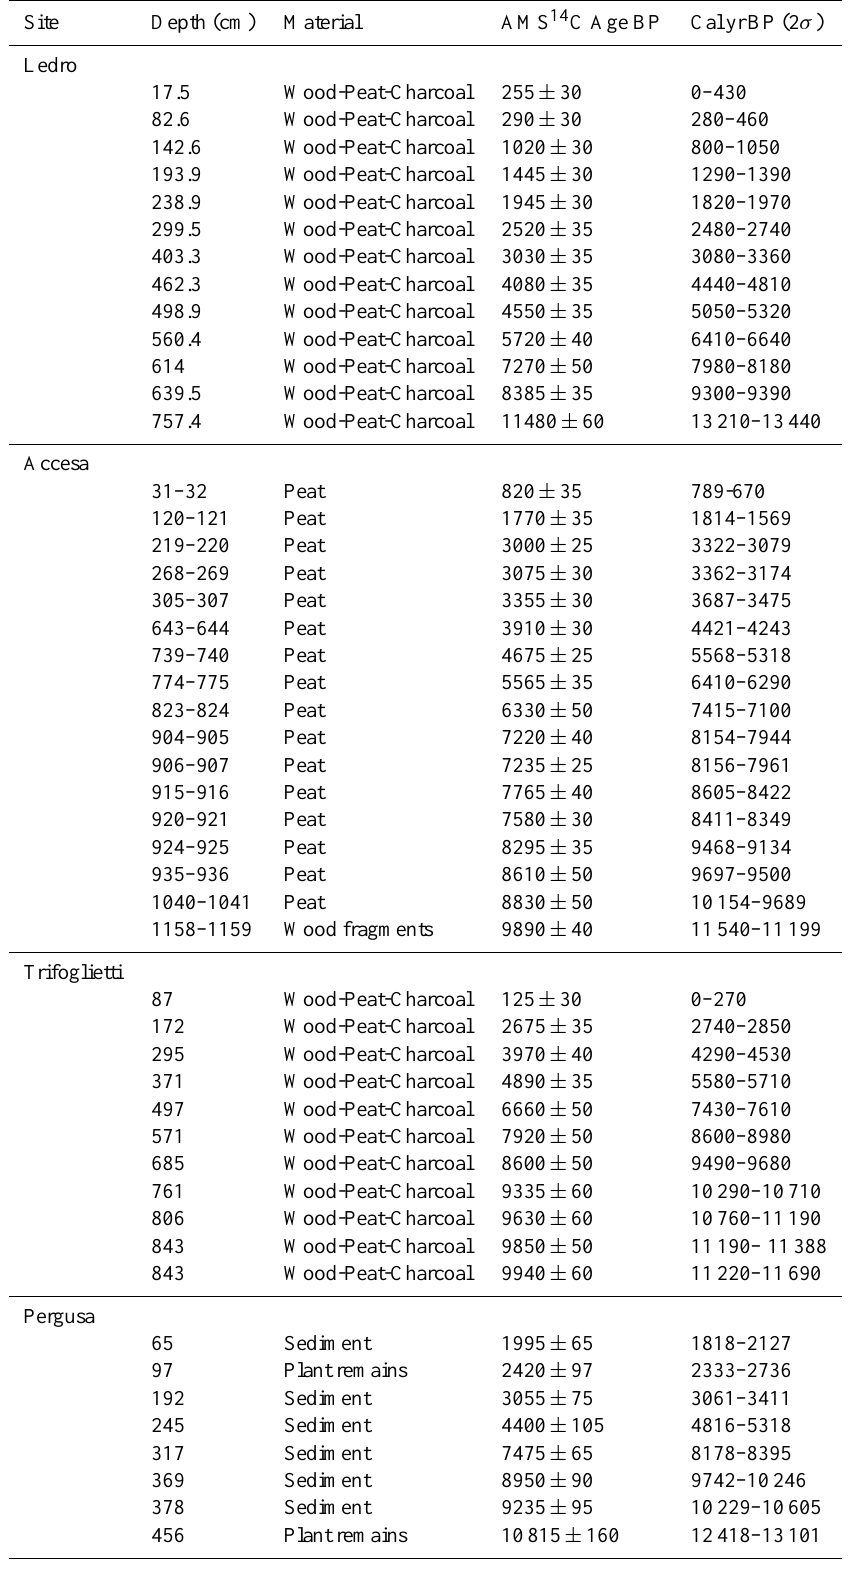
Table 1. Chronologies: information on the radiocarbon dates used for each